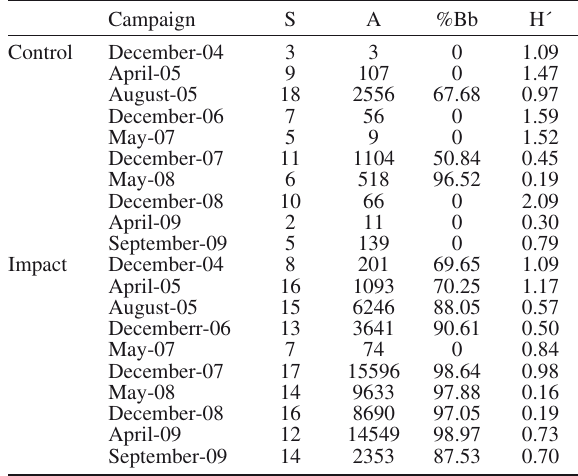
Table 1. – Overall species fish richness (S; number of species), fish abundance (A; number of individuals per 11250 m –3 ), Boops boops relative abundance (%Bb) and Shannon diversity (H´) at control and impact locations throughout the study period